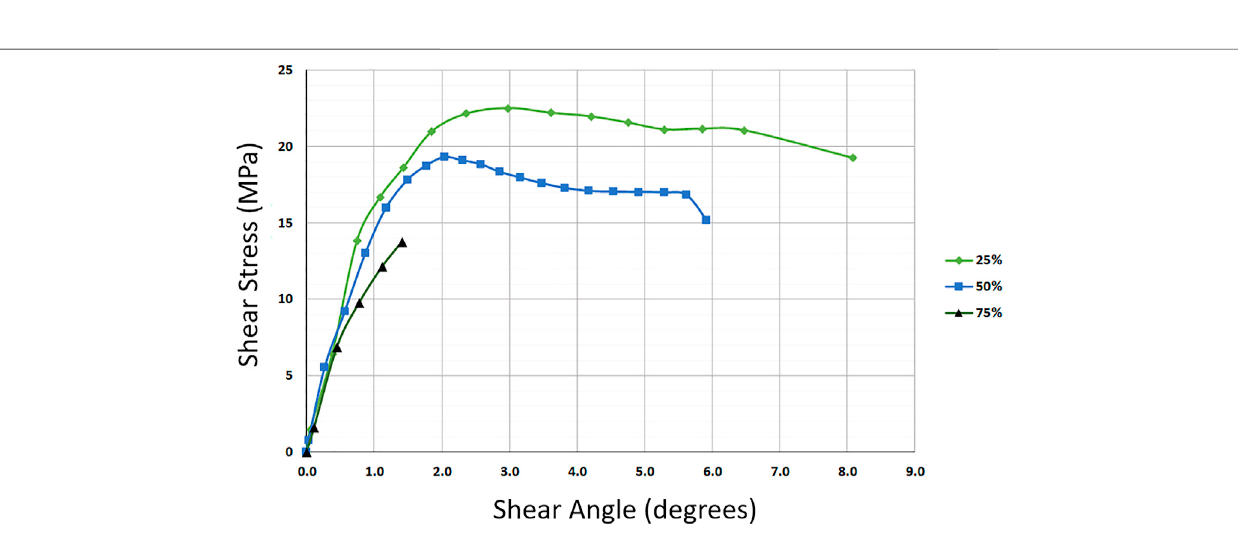
FIGURE 10 | PLA shear stress response at various coverage